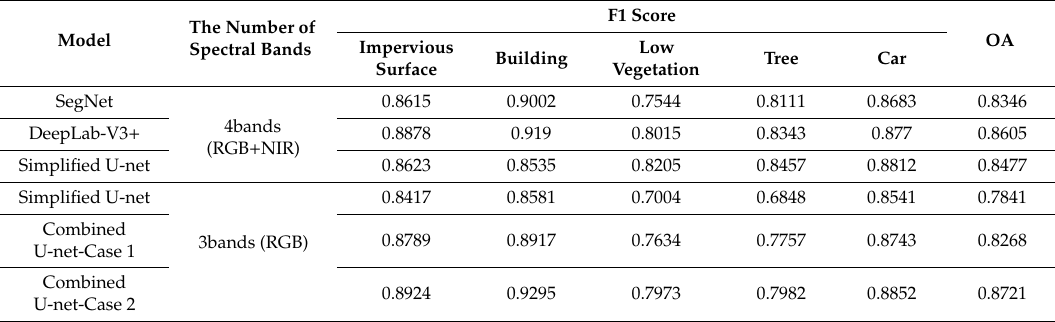
Figure 5. Final label classes of the Potsdam and Cityscape datasets. Table 3. F1 scores of the five classes and overall accuracy of the test set derived from the Potsdam dataset for the six considered cases.